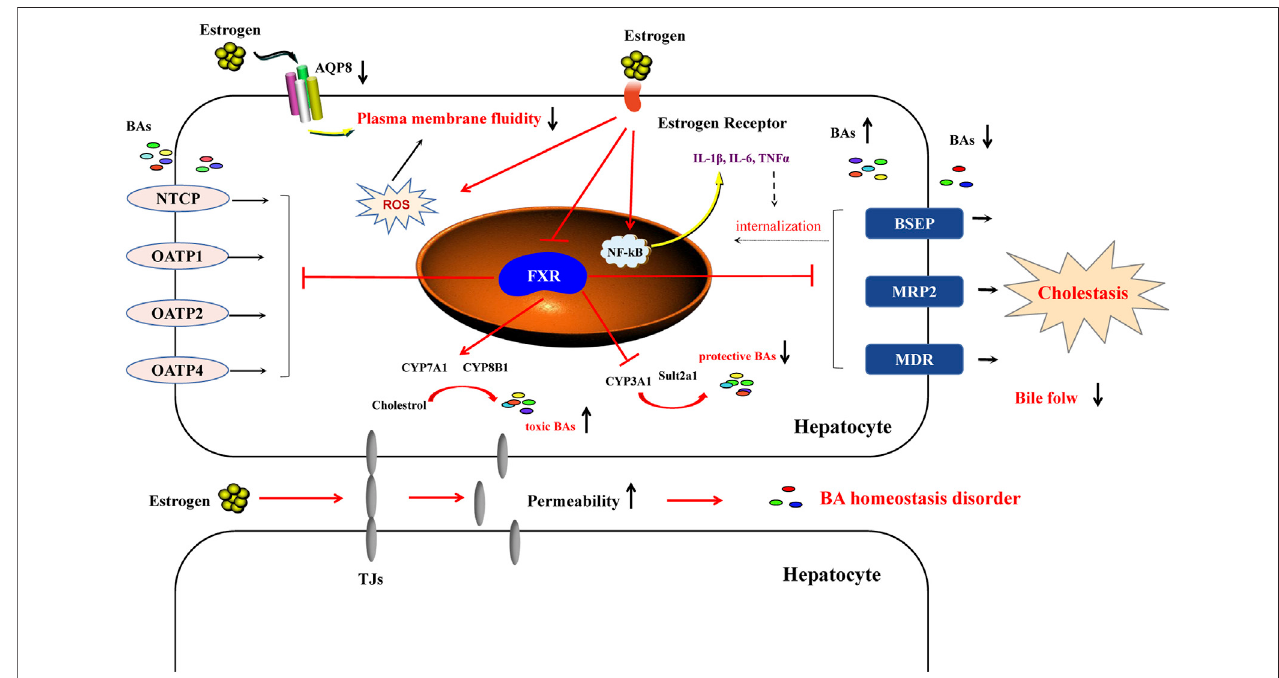
FIGURE 3 | The main pathological mechanism of estrogen-induced cholestasis. In the liver, estrogen enters the plasma membrane of the hepatocyte to interact withestrogenreceptors(ER α andER β ),whichcaninhibittheexpressionofFXRandthenregulatetheexpressionofdownstreamgenes.Estrogensincreasetheactivityof bile acid synthase (CYP7A1 and CYP8B1) and inhibit their metabolic enzymes (CYP3A1, CYP3A11 and Sult2a1), as well as promote the increase of bile acid content in hepatocytes. Regarding transporters, estrogens reduce the levels of BSEP and MRP2, as well as inhibit NTCP and OATPs, resulting in a decrease in bile fl ow. In addition, estrogen-induced cholestasis is related to the impaired membrane fl uidity. The increase of ROS and in fl ammatory response can also exacerbate estrogen- induced cholestasis liver injury. Estrogen can increase the permeability of TJs, leading to the imbalance of BA homeostasis and promoting the progress of EIC.